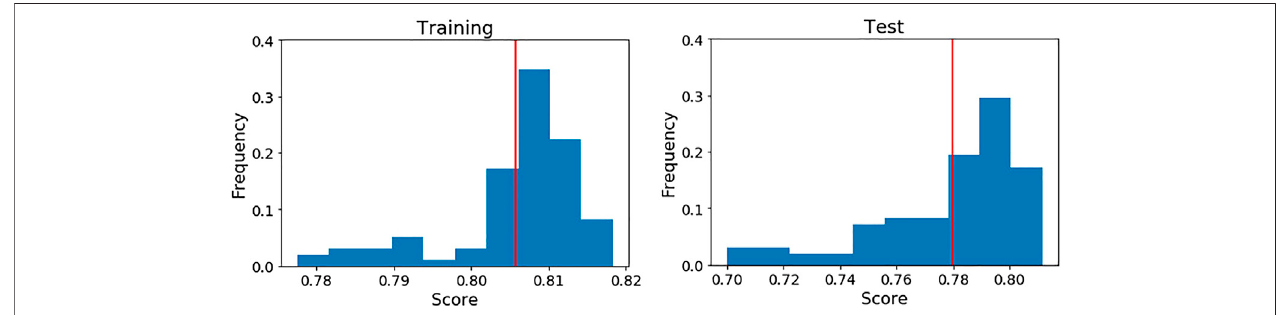
TABLE 7 | Results using the best set of features (KRFPC435, KRFPC566, KRFPC3948 and KRFPC4830) on each partition over the corresponding test sets.